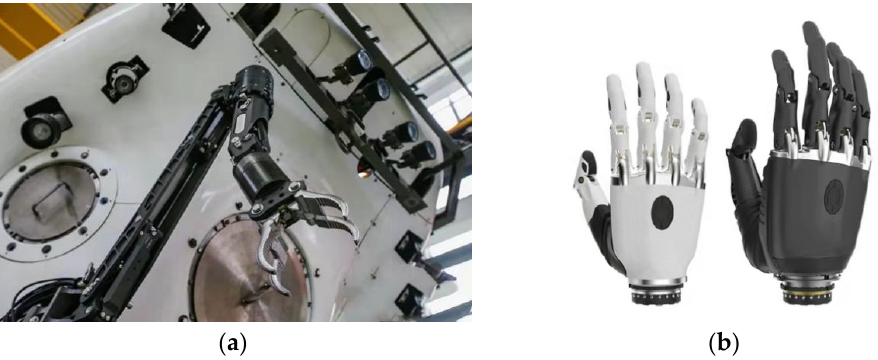
Figure 2. Typical manipulators: ( a ) Clamp type and ( b ) Hand type.